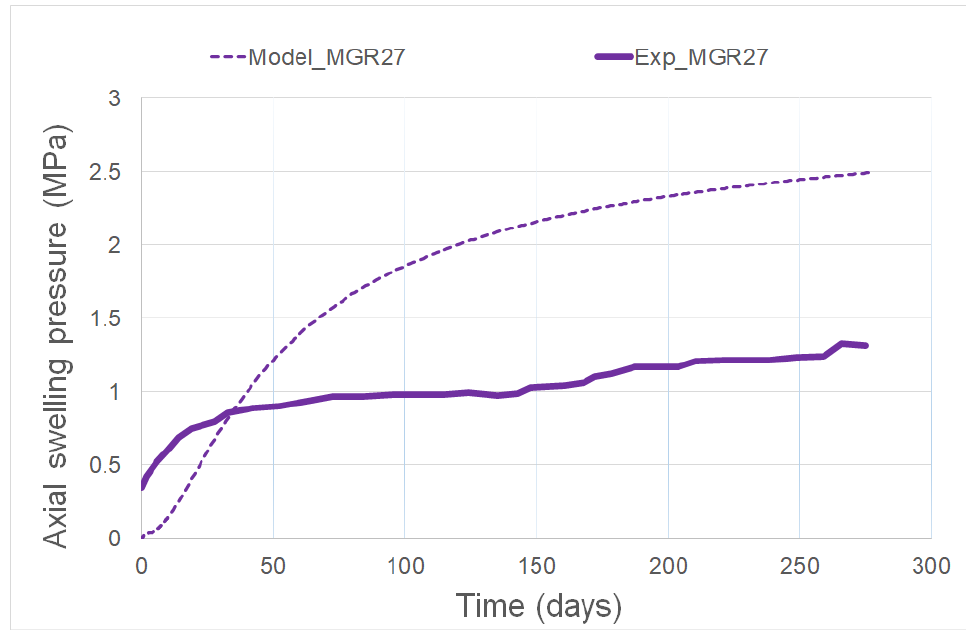
Figure 6. Comparison of modeling results (dashed lines) and the measurement (solid lines) of axial swelling pressure on the top of the MGR27 sample.